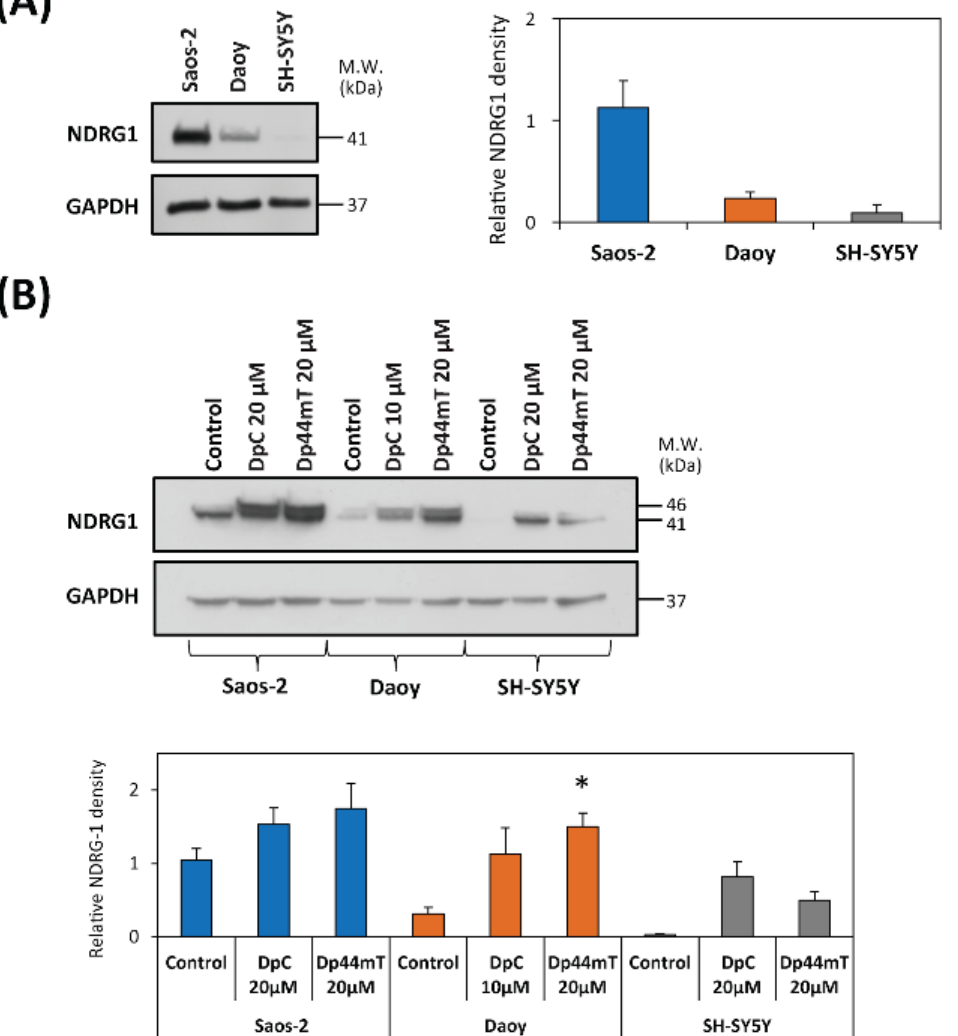
Figure 2. NDRG1 expression is markedly up ‐ regulated relative to the control after a 24 h/37 °C incubation with DpC or Dp44mT. ( A ) Western blot analysis of endogenous NDRG1 levels in untreated cells. GAPDH served as a loading control. ( B ) Western blot analysis of NDRG1 levels in Saos ‐ 2, Daoy and SH ‐ SY5Y cells after 24 h/37 °C of incubation with either control medium, DpC (20 μ M; 10 μ M for Daoy), or Dp44mT (20 μ M). GAPDH served as a protein loading control. All experiments were repeated at least three times. Western blots are typical of three experiments, while the quantitation of the blots is presented as mean ± SD (3 experiments). These data were analyzed by unpaired Welch’s t ‐ test followed by the Games ‐ Howell post hoc test. * p < 0.05 indicates significant differences compared to the respective control group.